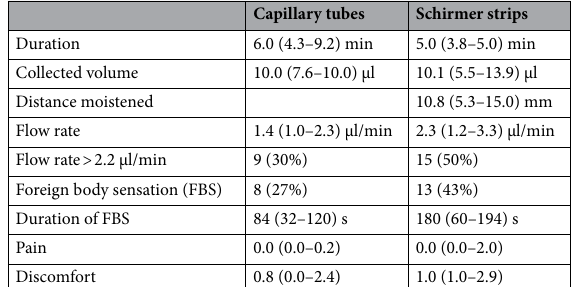
Table 1. Tear fluid collection from healthy subjects. Capillary tube and Schirmer strip samples were collected from both eyes. Values are displayed as median and interquartile range (IQR) or quantity (percentage of total number). n = 30 from 15